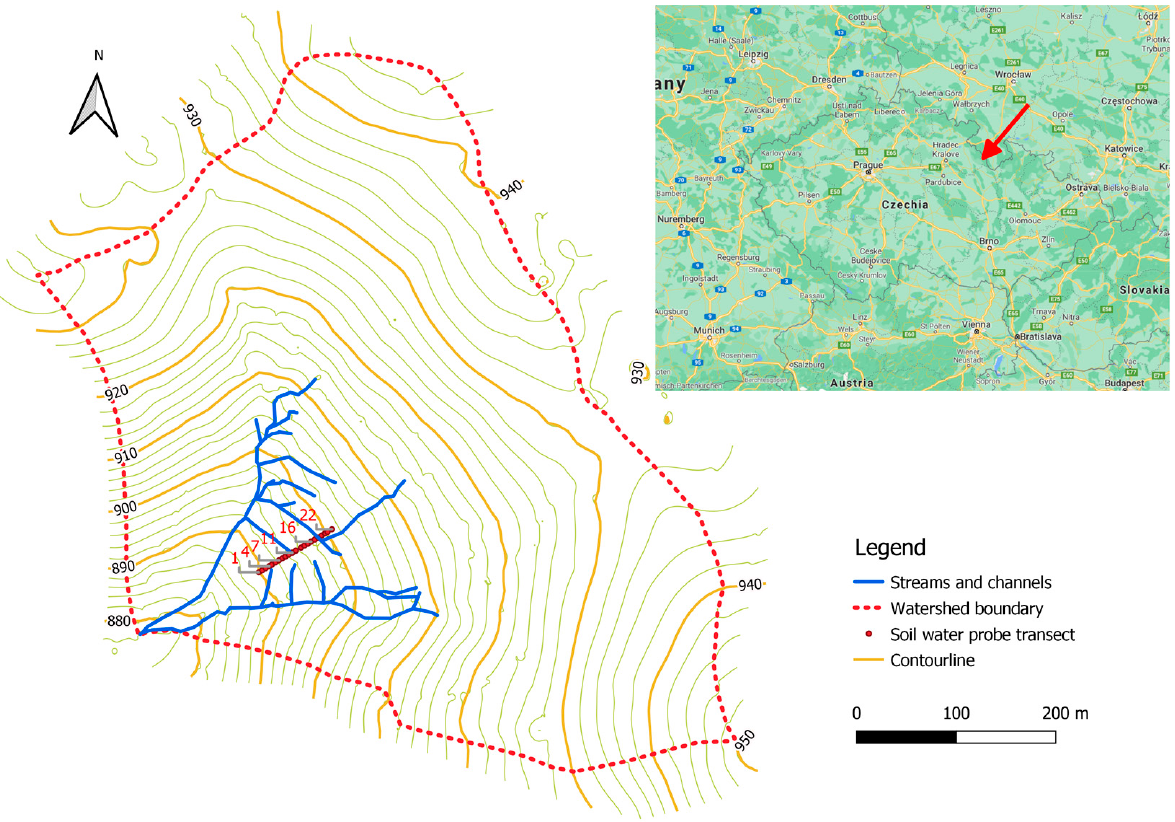
Figure 1. Location and geomorphology/terrain of the experimental catchment UDL with soil water probe transect; the numbers represent individual probes. Source of the top-right picture: Google Maps.